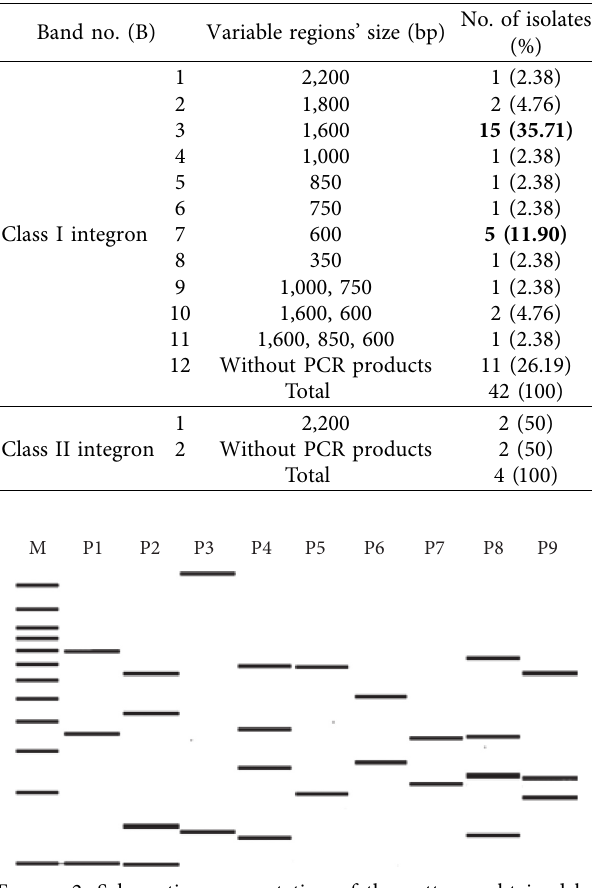
Table 3: The distribution of integron variable region’s sizes among tested E. coli